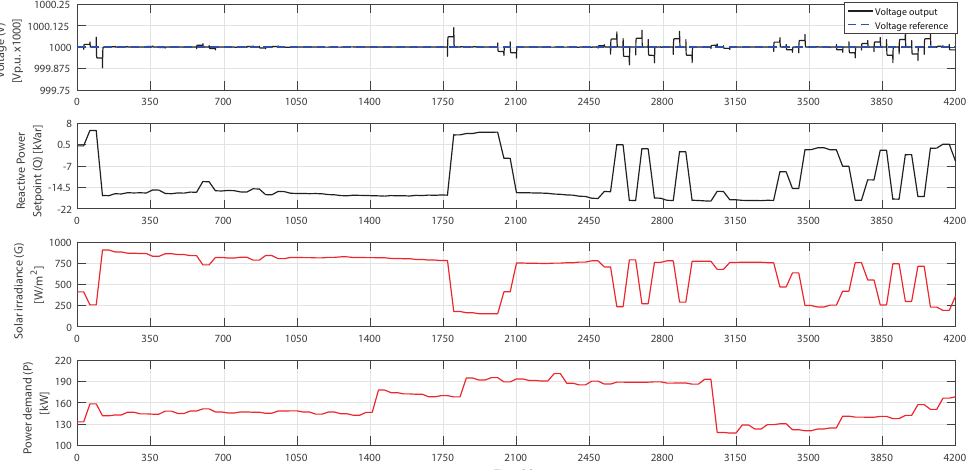
Figure 9. Model predictive voltage controller simulation results. Black-colored lines are controller outputs and red-colored lines are external